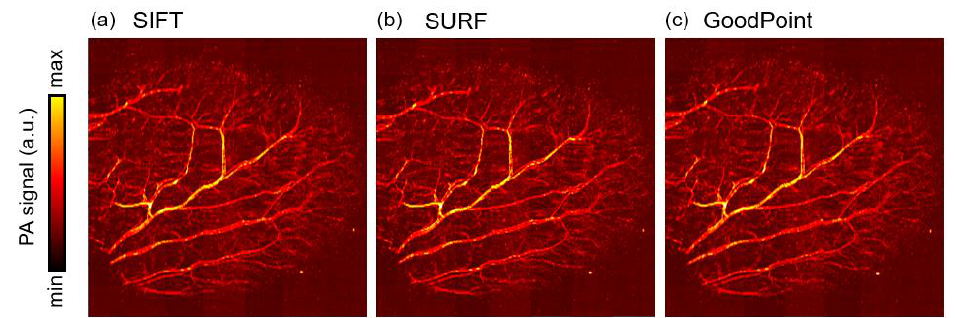
Figure 7. Whole mouse ear mosaic OR-PAM MAP images based on the feature detection algorithms ( a ) SIFT, ( b ) SURF, and ( c ) GoodPoint. ( a ) SIFT, ( b ) SURF, and ( c )